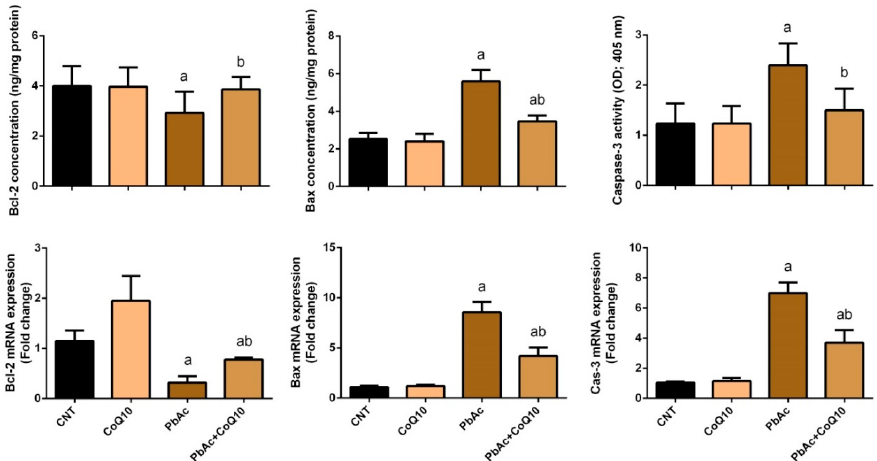
Figure 6. Effects of coenzyme Q10 on the cortical levels and gene expression of Bax, caspase-3, and Bcl-2 in mouse cortex neurons following lead acetate exposure. mRNA Results are represented as the mean ± SD (n = 7); significant changes at P < 0.05 were determined using Duncan’s post-hoc test. a significant changes compared with the control group; b significant changes compared with the PbAc injected group. Data for qRT-PCR are expressed as the mean ± SD of triplicate assays normalized to β -actin and expressed as fold changes (log2 scale) compared with the mRNA levels of the control group.